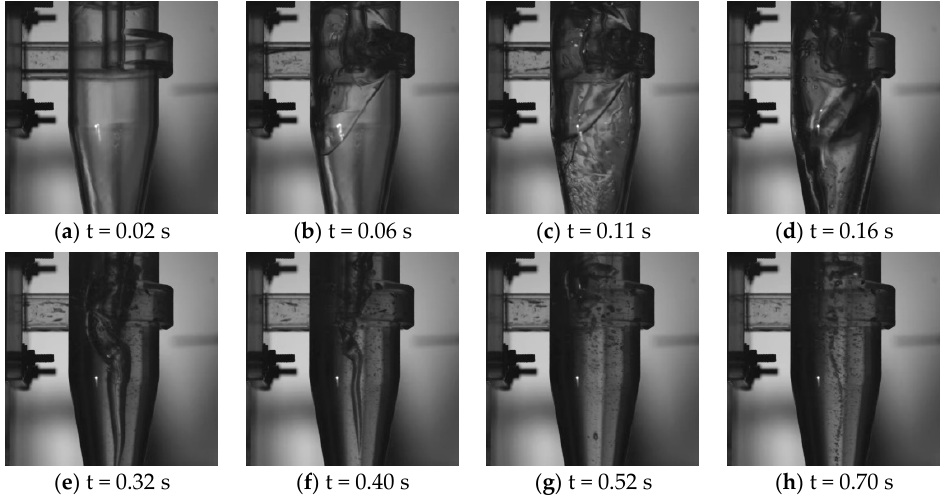
Figure 14. Bubble flow process in a cyclone with rectangular inlet.